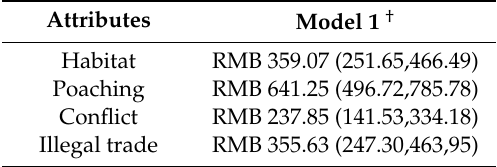
Table 5. Willingness to pay for conservation attributes.